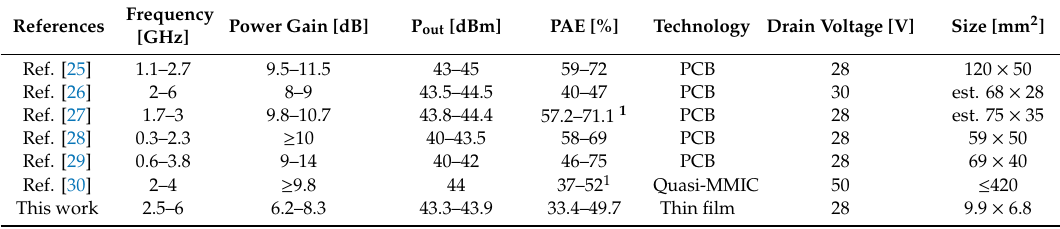
Table 2. Comparison of our work and previously published wideband GaN HEMT power